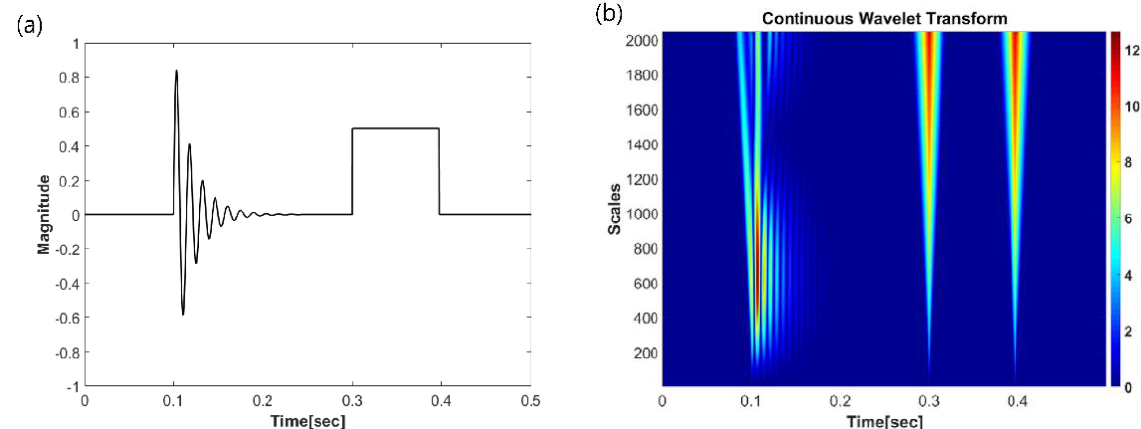
Figure 5. An impact signal with a burst noise ( a ) and its CWT ( b ).